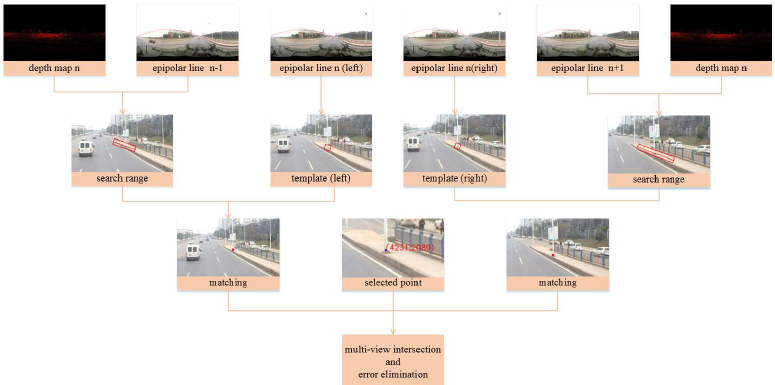
Figure 5. Depth map supported multi-view matching. The left and right stereos are matched separately and in multi-view intersection, mistakenly matched candidates could be observed and eliminated.